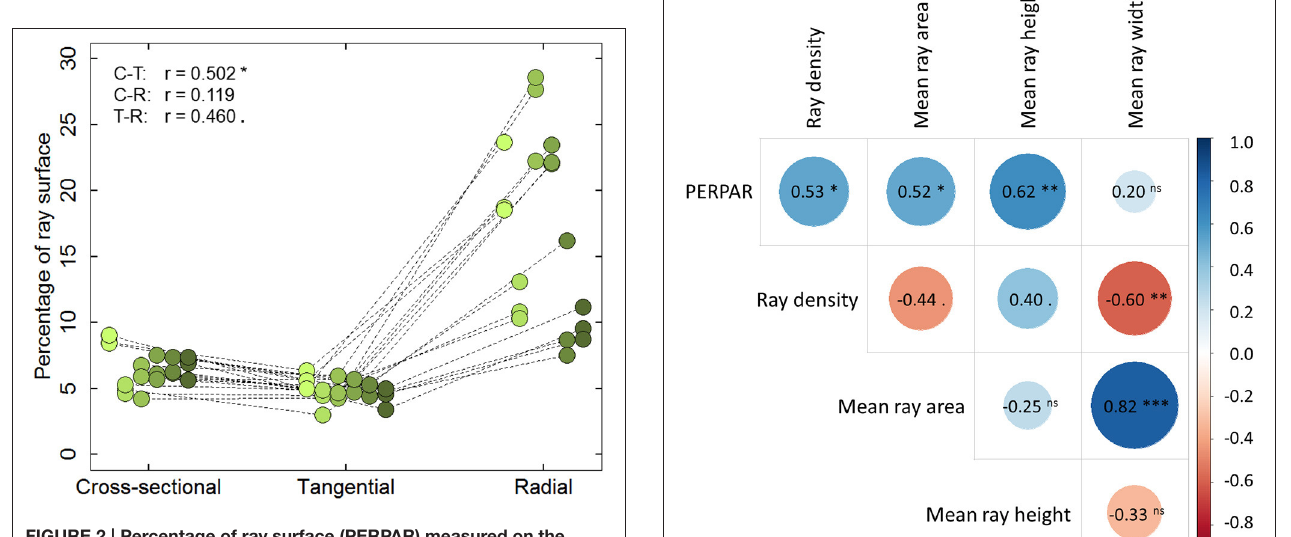
FIGURE 2 | Percentage of ray surface (PERPAR) measured on the cross-sectional, tangential and radial planes at three tree-rings (1989, 2002, and 2012) along the radial cores of six mature Scots pine trees. Symbols of the same color represent the PERPAR values of a specific cutting. Dotted lines connect the measurements from the same tree and ring. Symbols of the same cutting plane are jittered along the x-axis for easier interpretation. Left upper data indicates the Pearson correlation coefficient ( r ) between cross- and tangential sections (C-T), cross- and radial sections (C-R), radial and tangential sections (R-T), respectively. * P ≤ 0.05 ; · P ≤ 0.1 .